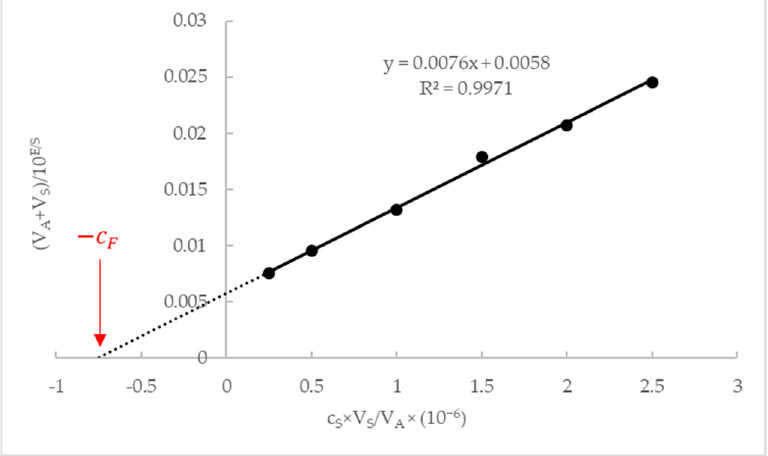
Figure 2. Graph of the proposed standard addition method application for fluoride determination in wine sample aliquot R9.